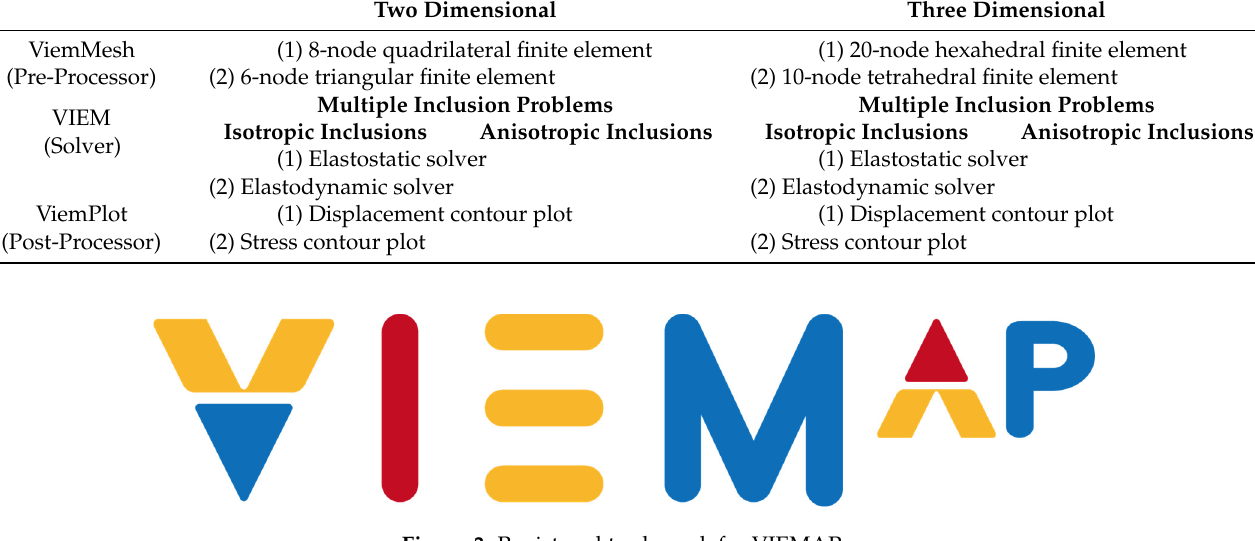
Figure 3. Registered trademark for VIEMAP.